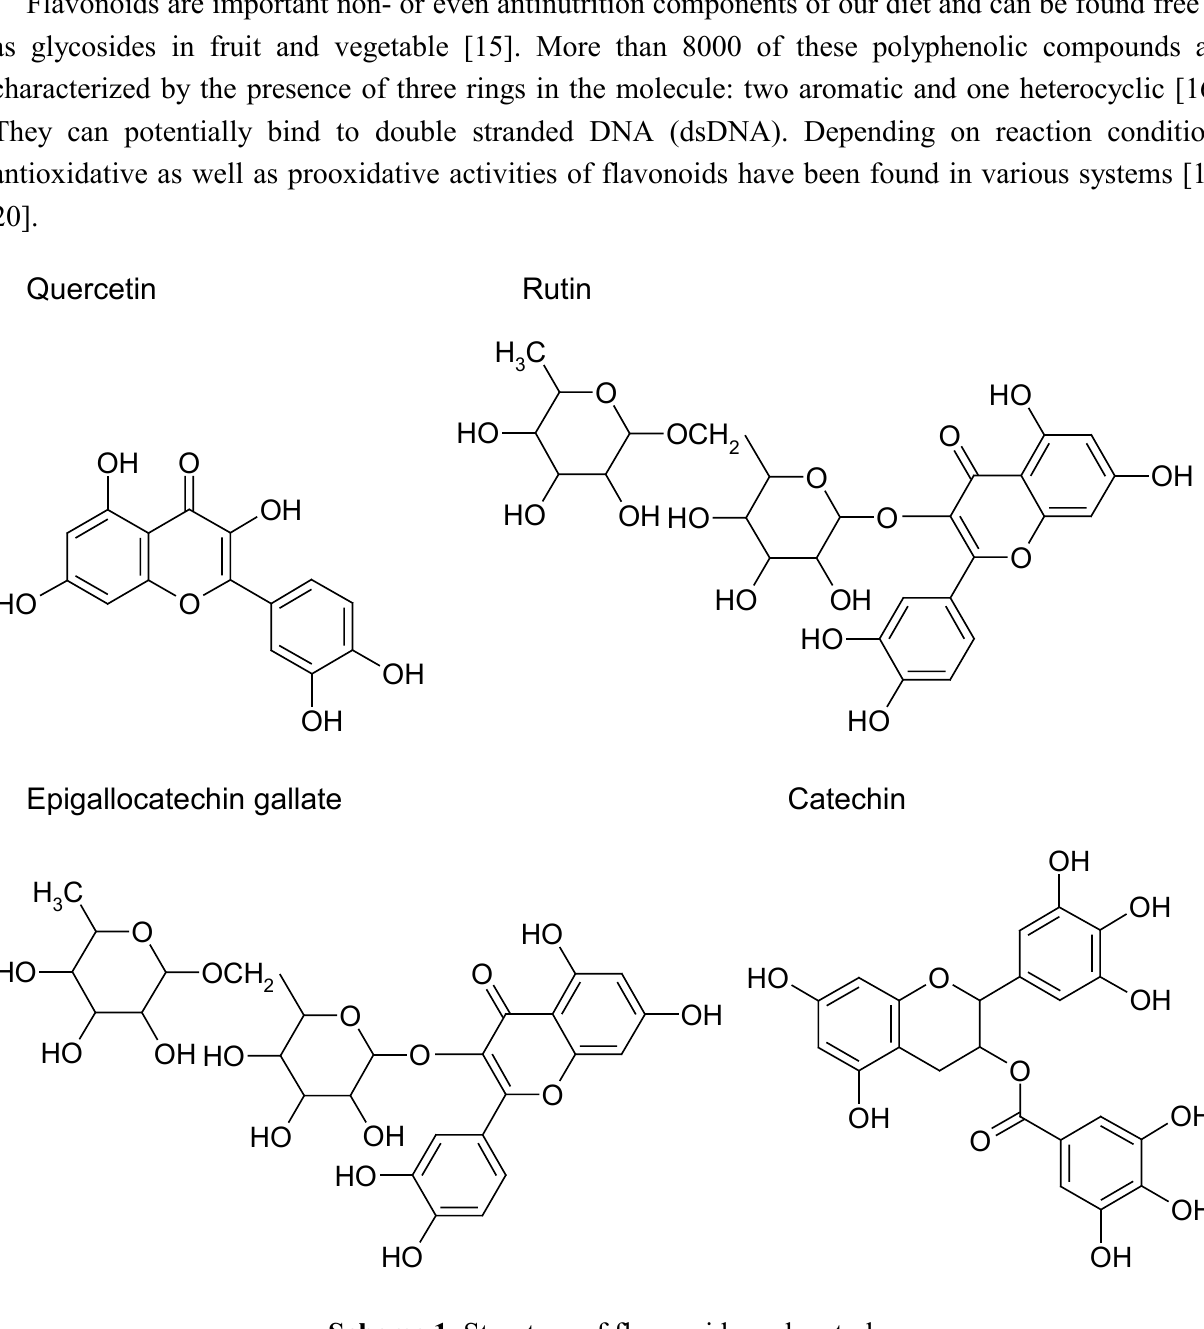
Scheme 1 . Structure of flavonoids under